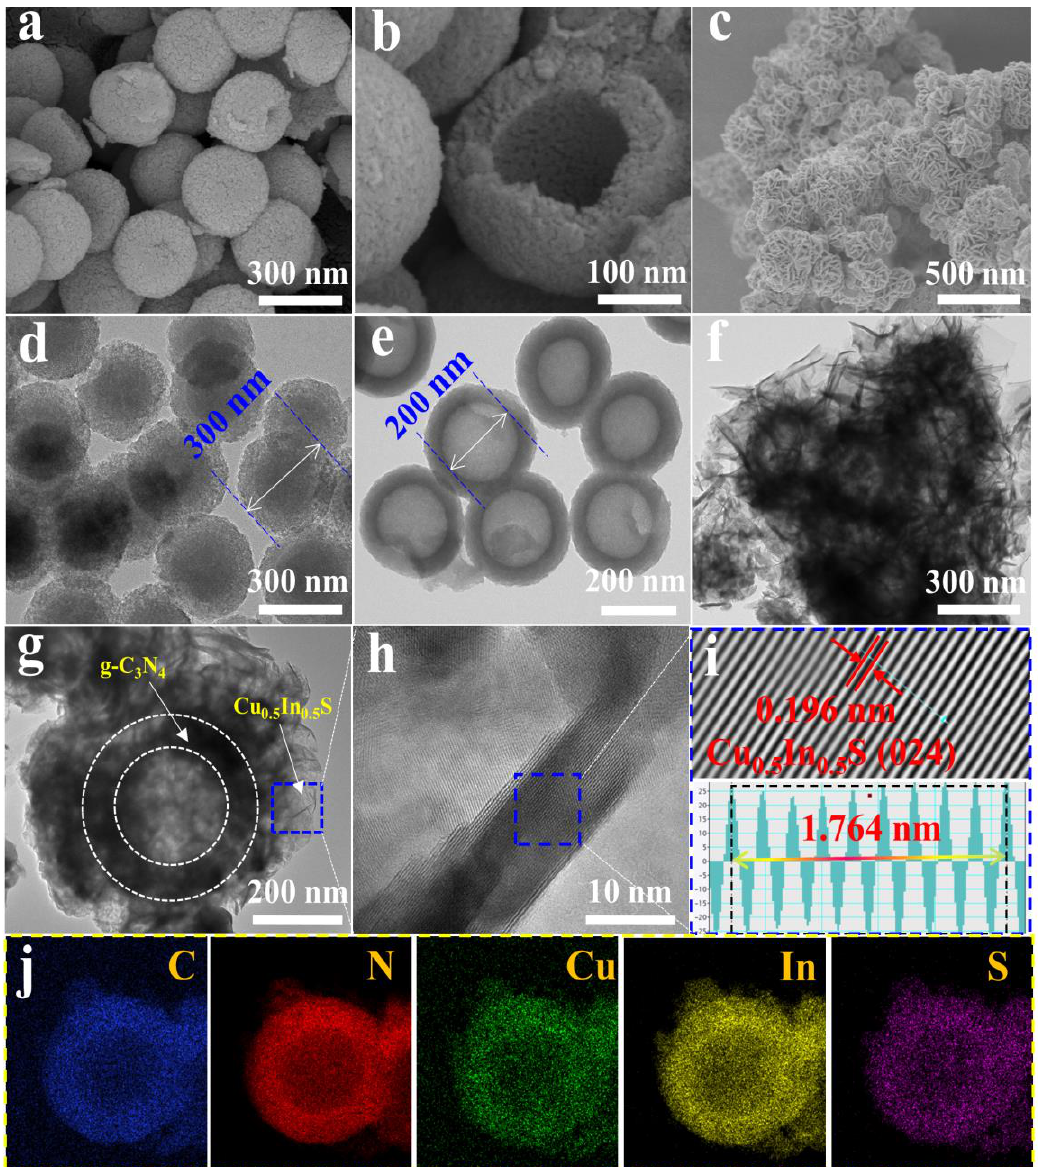
Figure 1. SEM images of HCN ( a , b ) and HCN@CIS ( c ). TEM images of SiO 2 @g-C 3 N 4 ( d ), HCN ( e ), and HCN@CIS ( f , g ). HRTEM images of HCN@ZIS ( h , i ). Elemental mapping images of HCN@CIS ( j ).